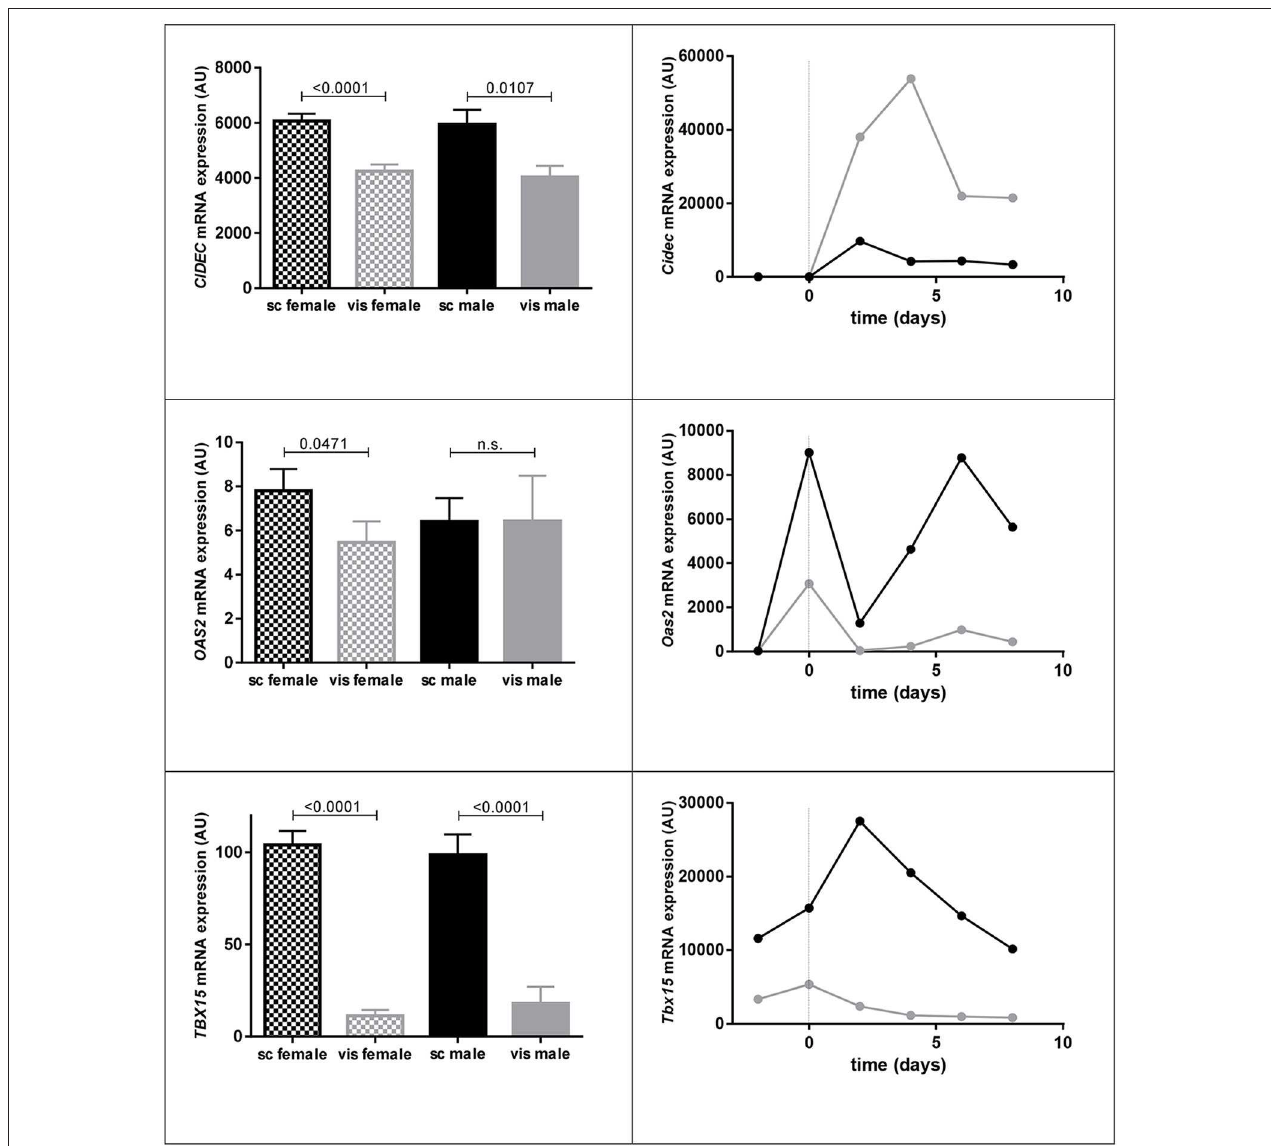
FIGURE 4 | Gene expression of significant differentially expressed genes in human adipose tissue [ N (females) = 47; N (males) = 16] and in mouse epididymal vs. inguinal cell line adipogenesis. On the left hand side data show subcutaneous (sc) and visceral (vis) adipose tissue gene expression means in males vs. females [arbitrary units (AU) ± standard error of the mean (SEM)]. P -values were calculated using Mann-Whitney-test. For HOXA10 the NM_153715.1 transcript variant 1, CD36 the NM_001001548 transcript variant 3 [transcript variant 1 presents almost same expression levels], for ACE the transcript variant 1 of NM_000789.2 and for OAS2 the transcript variant 2 of NM_002535.2 is shown. On the right hand side data show mRNA expression in epididymal and inguinal mouse cell lines from 2 days before until 8 days after day of induction (dotted line; day 0). In black the mRNA expression of inguinal (corresponding to subcutaneous) and in gray the mRNA expression in epididymal (corresponding to visceral) cell line is